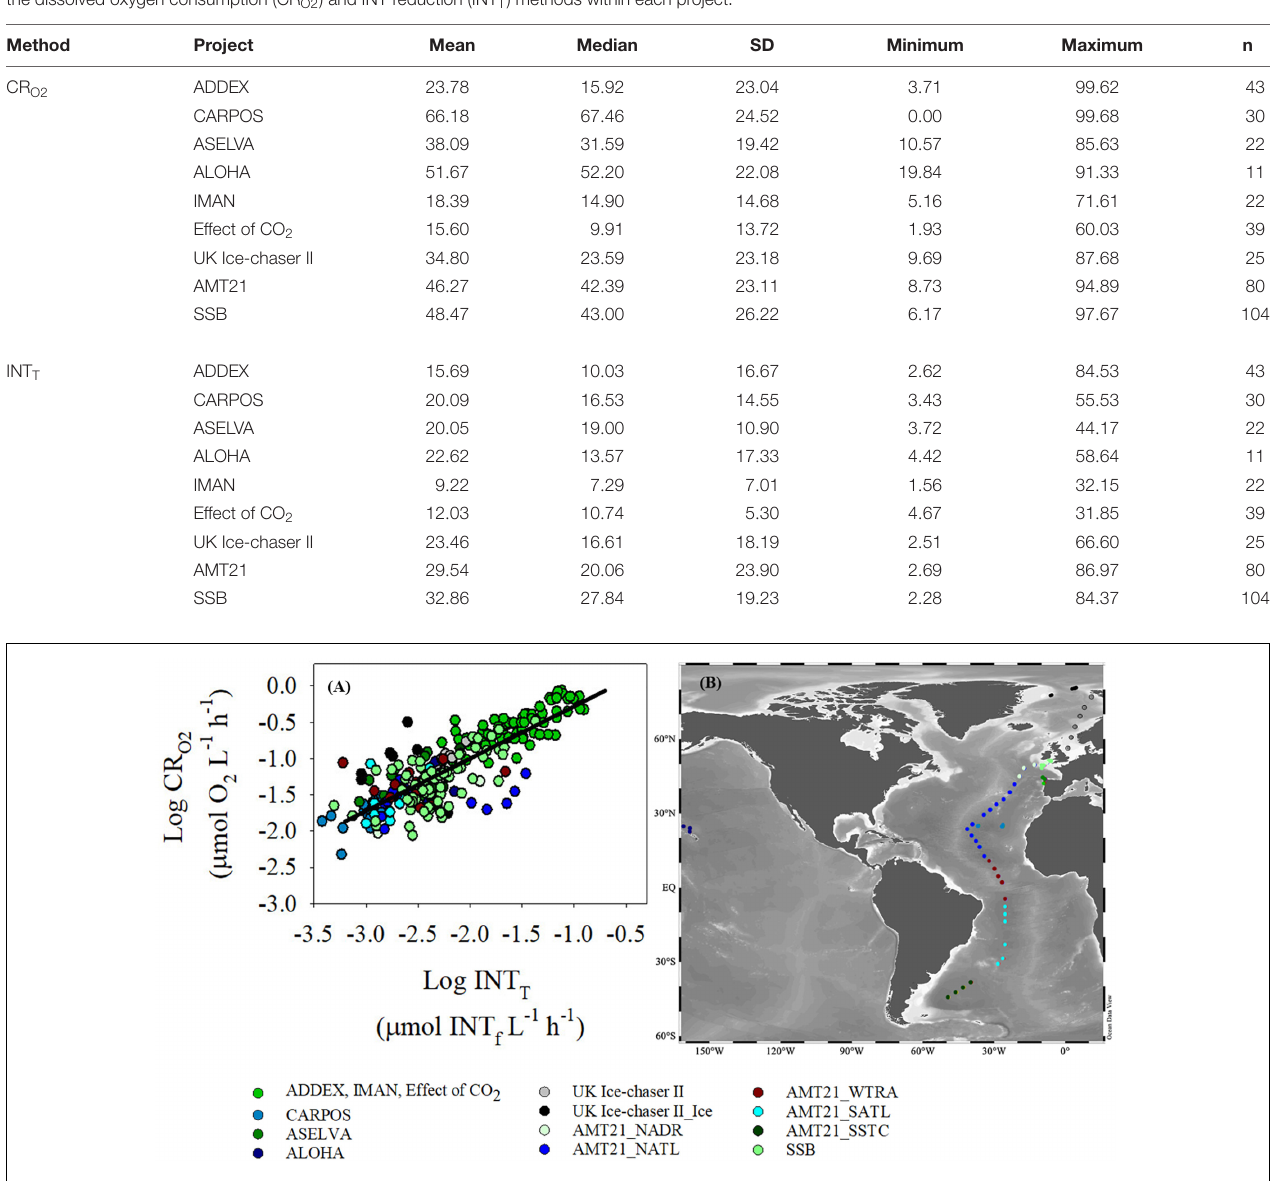
FIGURE 3 | (A) Log-Log relationship between dissolved oxygen consumption (CR O2 ) and INT reduction (INT T ) determined with the “training” dataset. Ordinary least square linear regression is logCR O2 = 0.72( ± 0.03) ∗ logINT T + 0.44( ± 0.07), R 2 = 0.69, n = 249, p < 0.001 (black line). (B) Map of the sampling points. The colors of the two graphs represent different regions of the oceans where data were collected. The data from the UK Ice-Chaser II project are divided into two different subgroups: data from open water stations (grey) and data from ice stations (black). Similarly, data from AMT21 have been divided into five subgroups: North Atlantic Drift Province (NADR), North Atlantic Tropical Gyre (NATL), Western Tropical Atlantic (WTRA), South Atlantic Subtropical Gyre (SATL), and South Subtropical Convergence